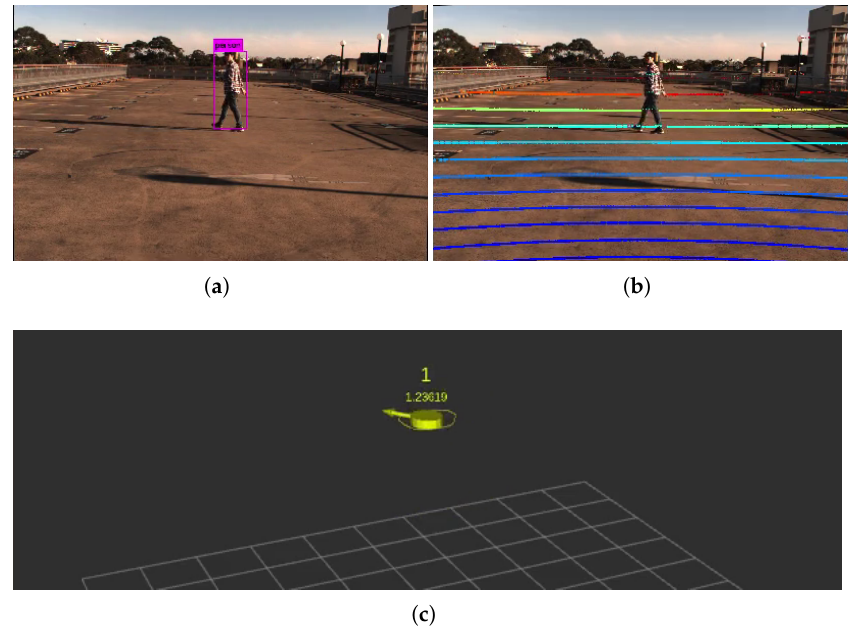
Figure 3. Pedestrian tracking setup for the IRSU. ( a ) shows the detection of the target pedestrian within a camera image using YOLOv3. The lidar points are projected to the image frame with extrinsic calibration parameters. The projected points in ( b ) are colour coded based on their range to the sensor in 3D space. Those bold points indicate those hitting the ground plane. ( c ) demonstrates the tracking of the pedestrian in 3D space. The RTK antenna was hidden within the cap of the pedestrian to log GNSS positions as the ground